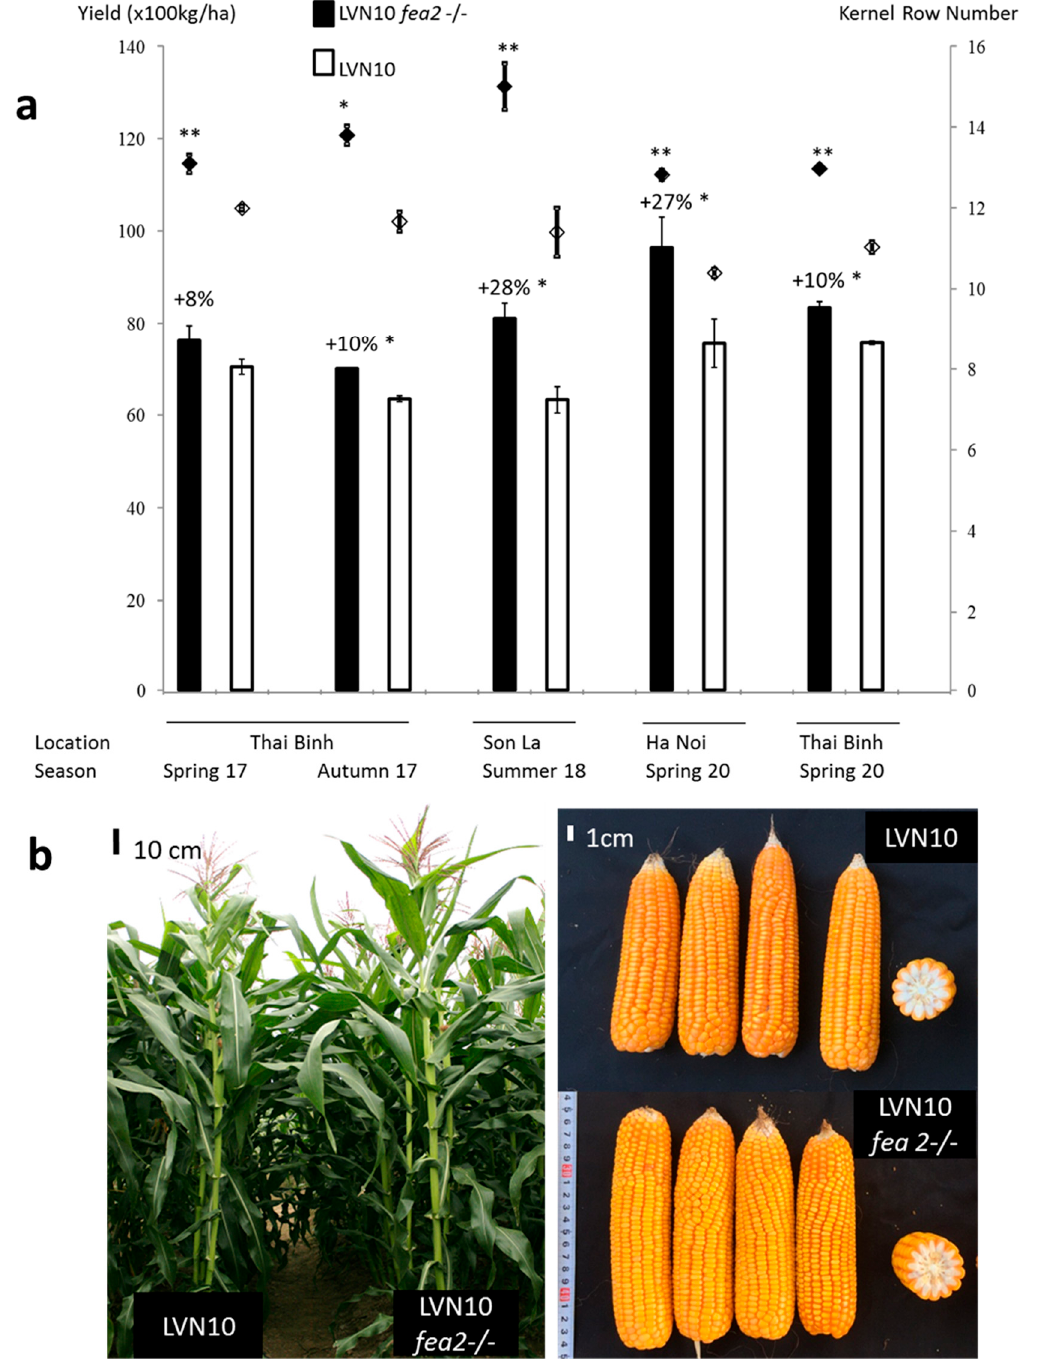
Figure 5. Yield trial of the original LVN10 hybrid and the LVN10 hybrid with fea2-1328 introgressed (LVN10 fea2 - / -). ( a ) Yield trial data. Columns showed yields and diamond dots showed KRNs. Unfilled symbols are LVN10 control; black-filled symbols are LVN10 fea2 - / -. Percentages of yield increase over original LVN10 were showed on top of the columns. Yield trials were carried out in three different locations and four seasons as shown. * and ** symbols indicate significantly different by Student’s unpaired t -test at p < 0.05 and p < 0.01, respectively. Error bars are s.e.m, n ≥ 3 for yield; n ≥ 20 for KRN. ( b ) Example images of plants and ears of LVN10 and LVN10 fea2 - / - taken in Son La in summer 2018.